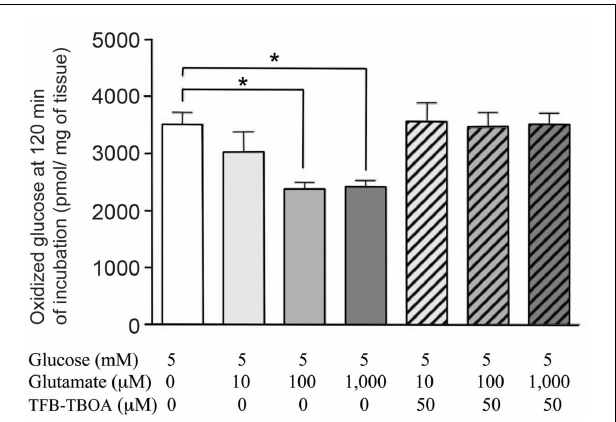
FIGURE 6 | Glucose oxidation rates of intact rat hippocampi, incubated in tissue culture medium for 2h with [U- 14 C] glucose . FromTorres et al.